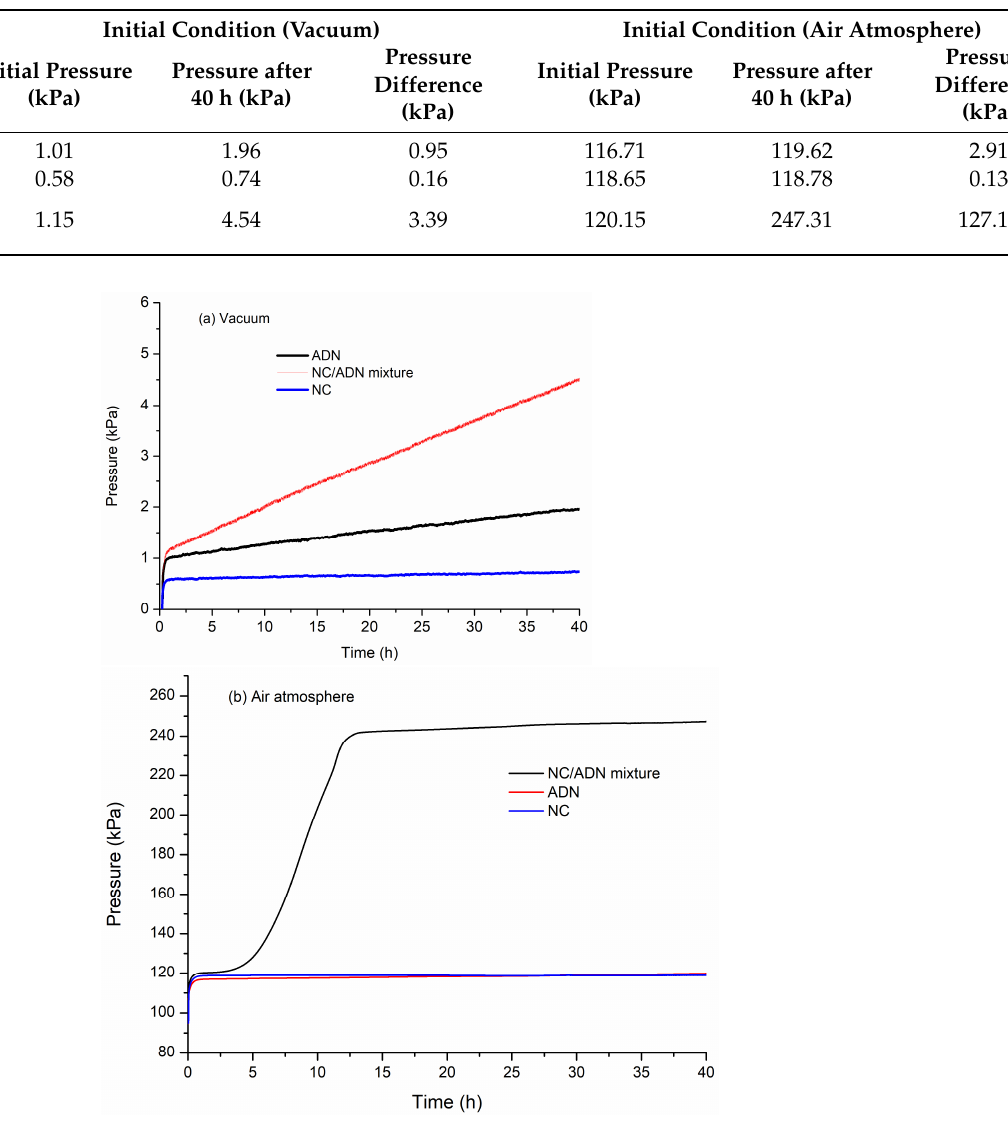
Table 3. Characteristic pressure data of ADN, NC and NC/ADN mixture.